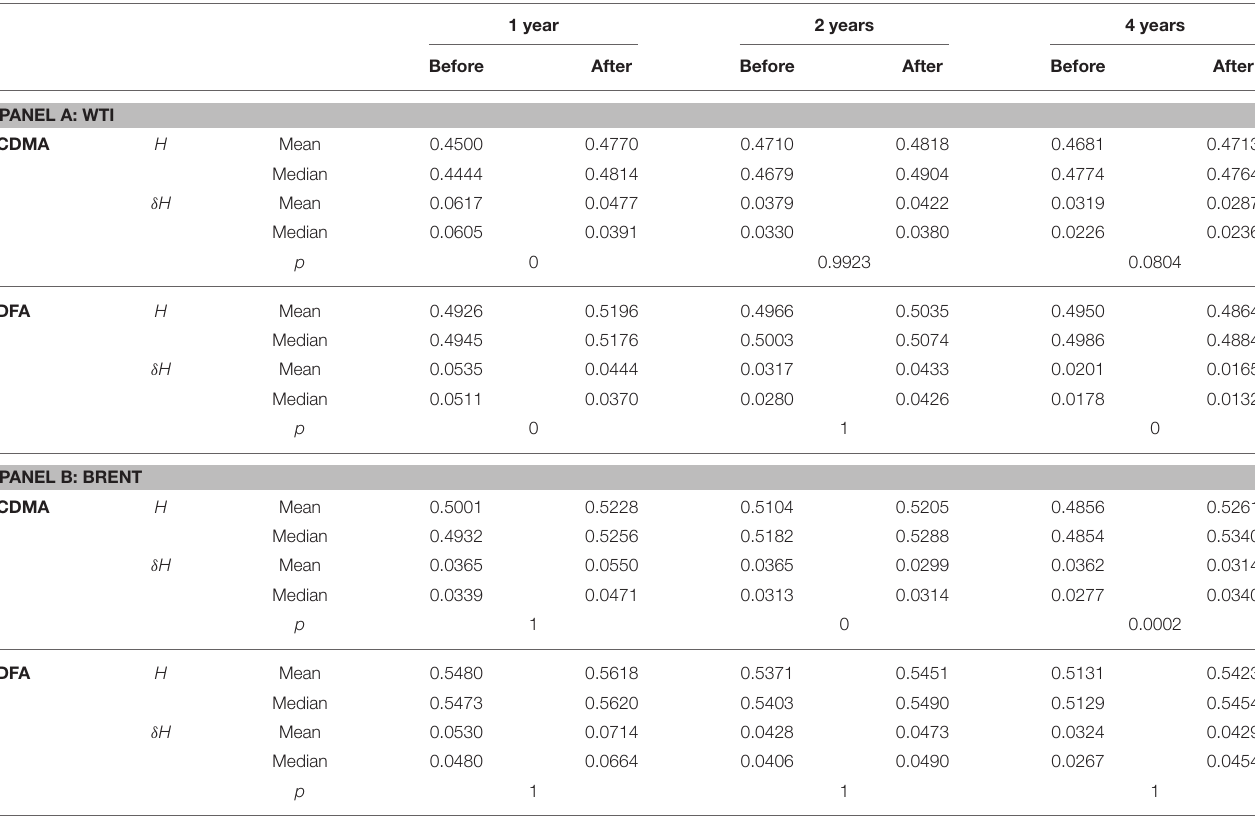
TABLE 1 | Statistics for Hurst exponent and δ H before and after the